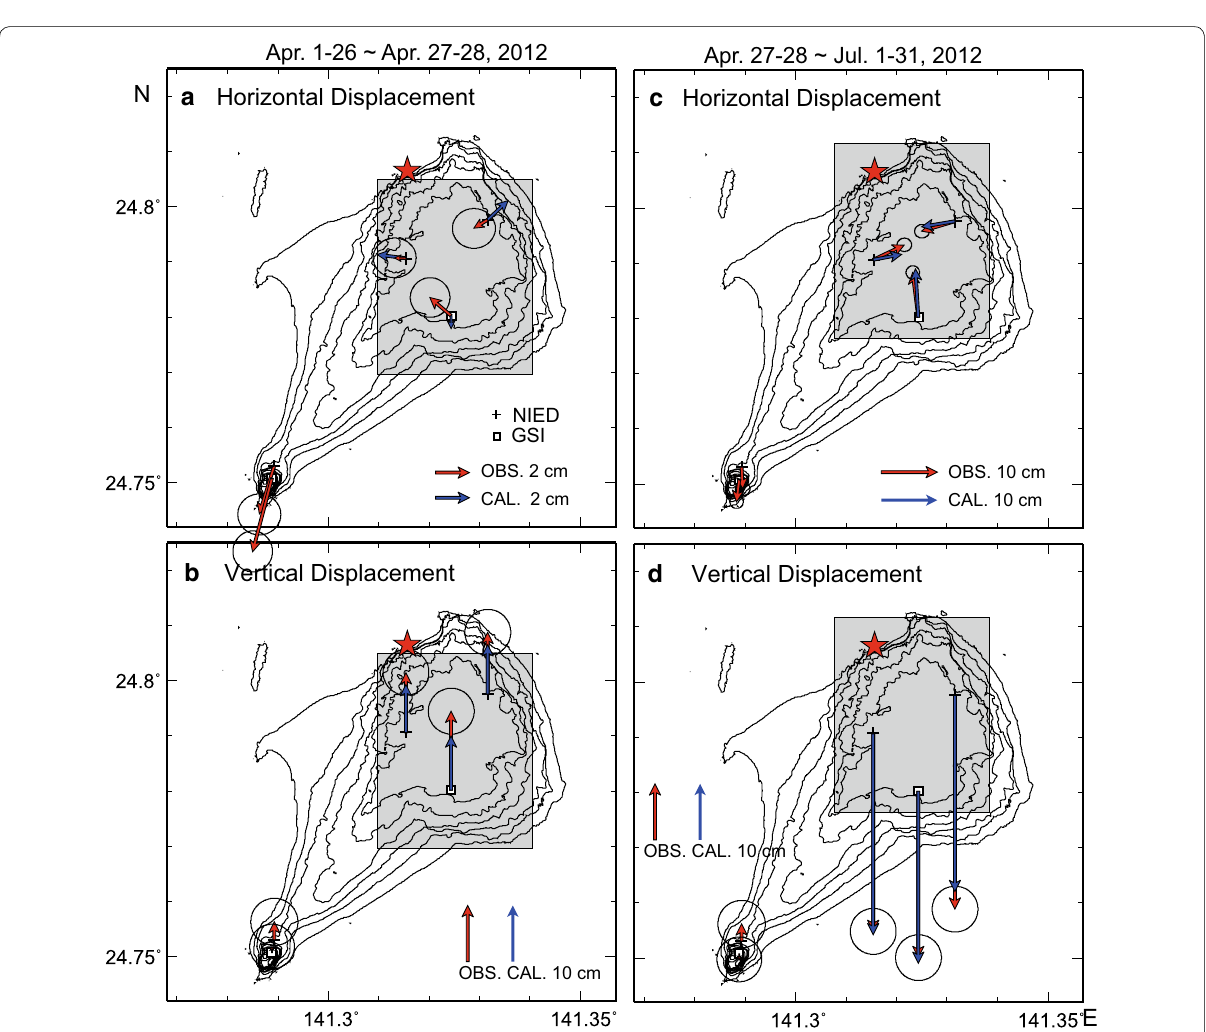
Fig. 7 A comparison of observed crustal deformation (red arrows) with that calculated (blue arrows) by the best-fit sill-like deformation source (gray rectangles) of a , b before and c , d after the beginning of the eruption of April 29, 2012. Red stars show eruption points. Displacement vectors are relative to the 0603 station of GSI (see Fig. 1a for